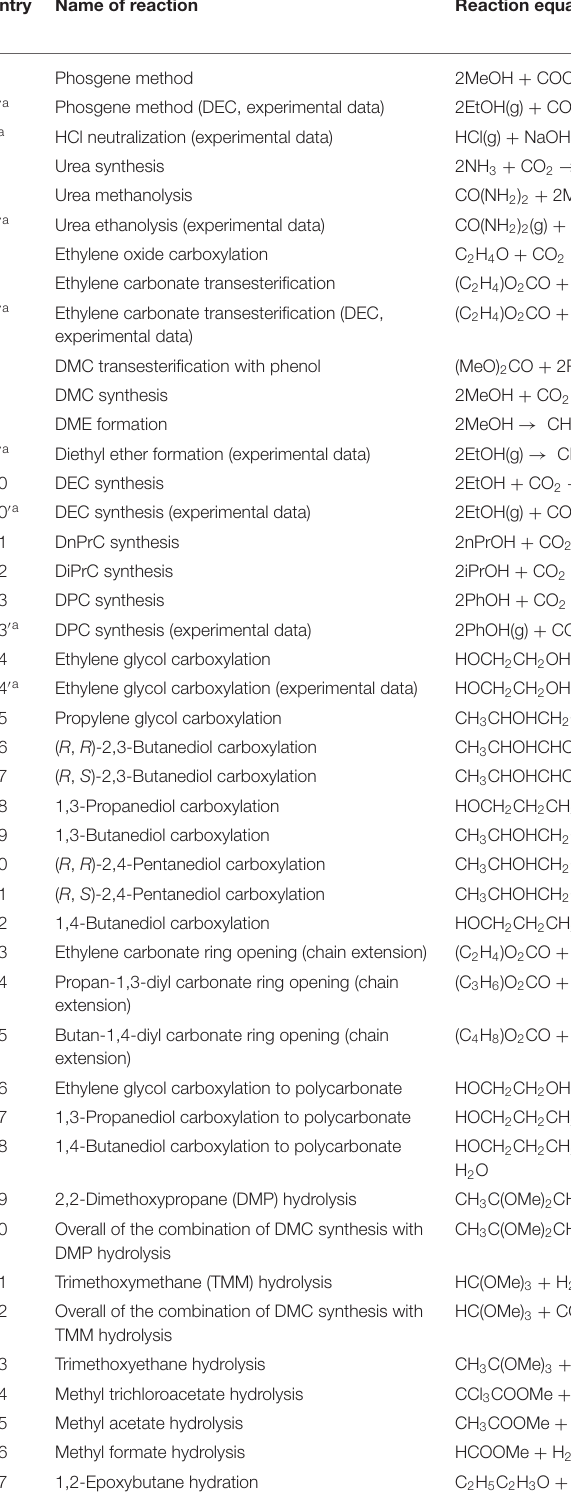
TABLE 1 | Summary of energy changes for related reactions for the synthesis of organic carbonates by DFT calculation (calculated at B3LYP/6-311 ++ G(d,p) level theory with Gaussian 16 program package (Gaussian, Inc.) and the reference experimental data. Entry Name of